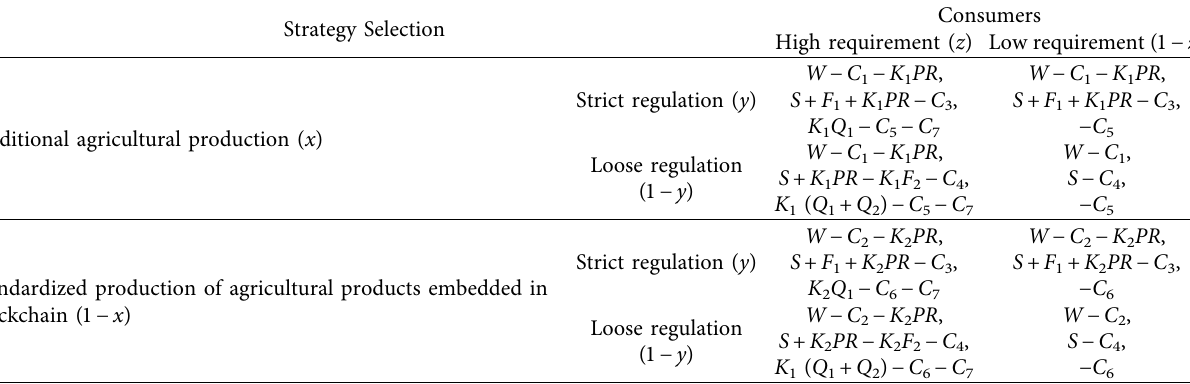
Table 2: Mixed strategy